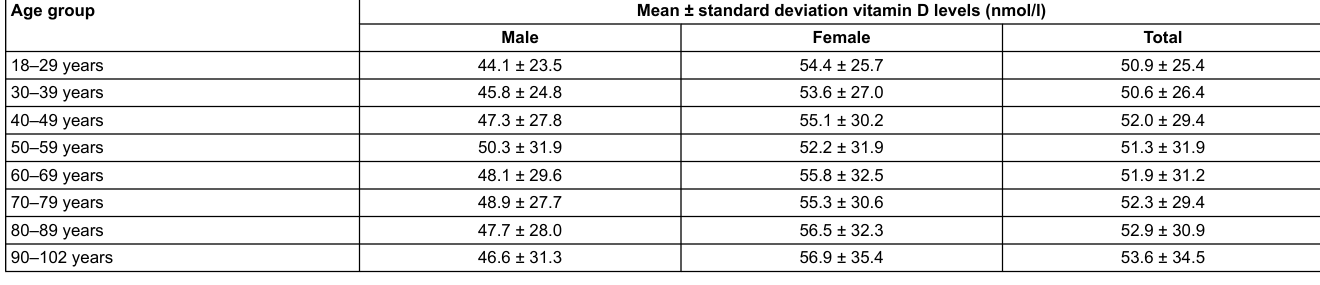
Table 3: Vitamin D concentrations by age groups and gender.